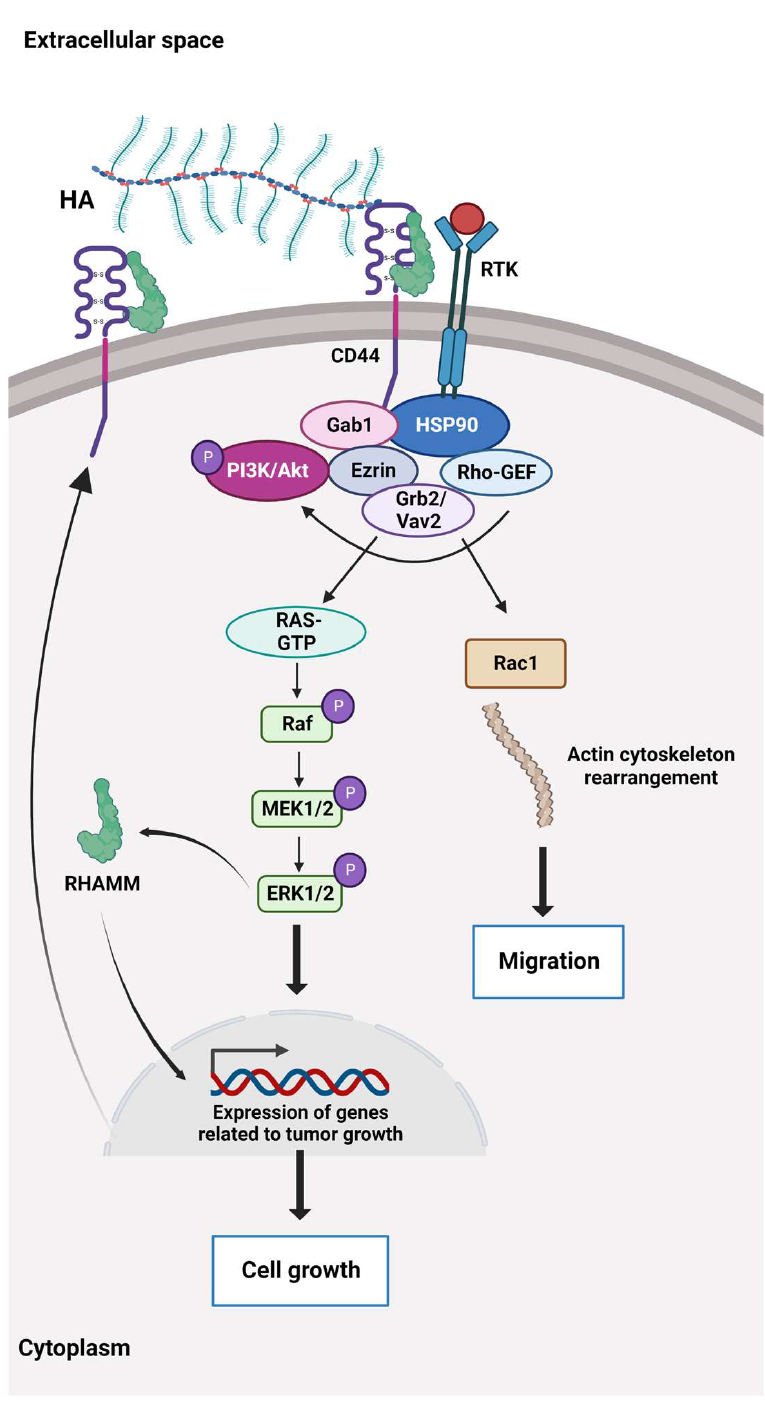
Figure 2. The HA-dependent CD44 signalling. CD44 and the receptor for hyaluronic acid (HA)- mediated motility (RHAMM) are the main HA receptors. They are commonly overexpressed in cancer, where they activate signalling pathways related to disease progression. CD44 also interacts with other ligands, such as collagens and matrix metalloproteinases, and as such, a multifunctional receptor mainly involved in proliferation, differentiation, migration, and angiogenesis. In contrast to membrane-bound receptors containing signalling domains, RHAMM (CD168) does not contain signal sequences. RHAMM is localised inside the cell and is exported to the cell surface in response to stimuli such as cytokines, including TGF-β. Extracellularly, RHAMM associates with CD44, and when HA binds to these cell surface receptors, it triggers several signalling pathways and complex formation between CD44 and its co-receptors and increases the expression of TGF-β receptors. Activation of downstream effectors, e.g., Akt, PI3K, MEK1/2, ERK1/2, and Ras/Raf/Rac, results in the expression of a variety of inflammatory cytokines and activation of a feedback loop augmenting cell surface expression of CD44/RHAMM. The CD44/RHAMM complex stimulates cell motility and increases angiogenesis by promoting the migration of endothelial cells towards the tumour. Further, these signalling events drive proliferation, invasion, and cytoskeletal rearrangements, leading to normal cell functions, such as fibroblast migration and immune cell function, and tumour growth and progression. ERK1/2: Extracellular signal-regulated protein kinases 1 and 2, Ezrin: kinase